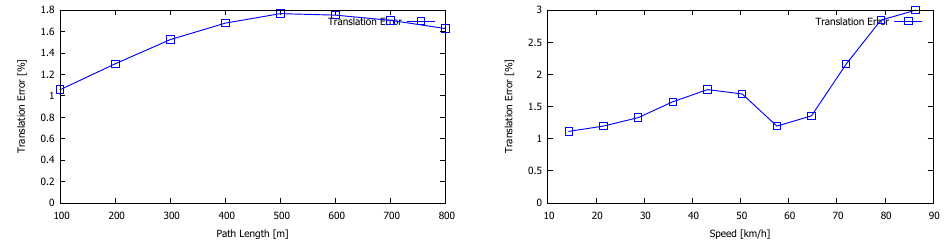
Figure 20. Results of the Kitti vision benchmark showing the average translation error of all test sequences. Left: the translation error is expressed as a function of the path length. Right: the translation error is expressed as a function of the speed.